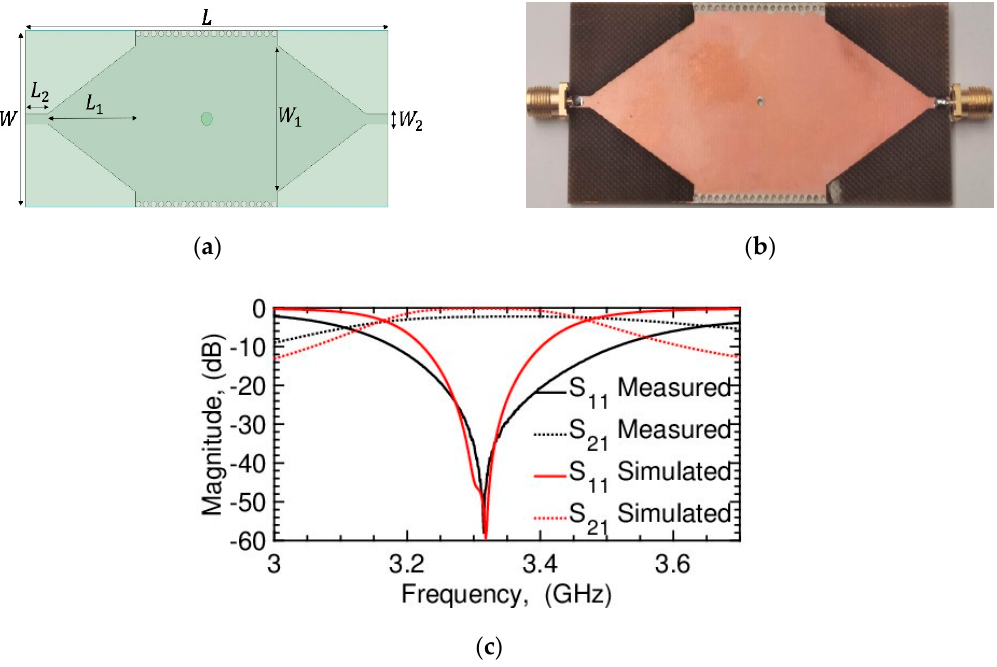
Figure 9. Fabricated filter on FR4 using second-mode TE 11 approach. ( a ) Schematic of 3.2 GHz FR4 simple narrow-band filter; W = 36.1 mm, W 1 = 30 mm, W 2 = 2 mm, L = 32.15 mm, L 1 = 25 mm, and L 2 = 1 mm. ( b ) Photograph of fabricated filter. ( c ) Simulated and measured S-parameters of proposed filter.